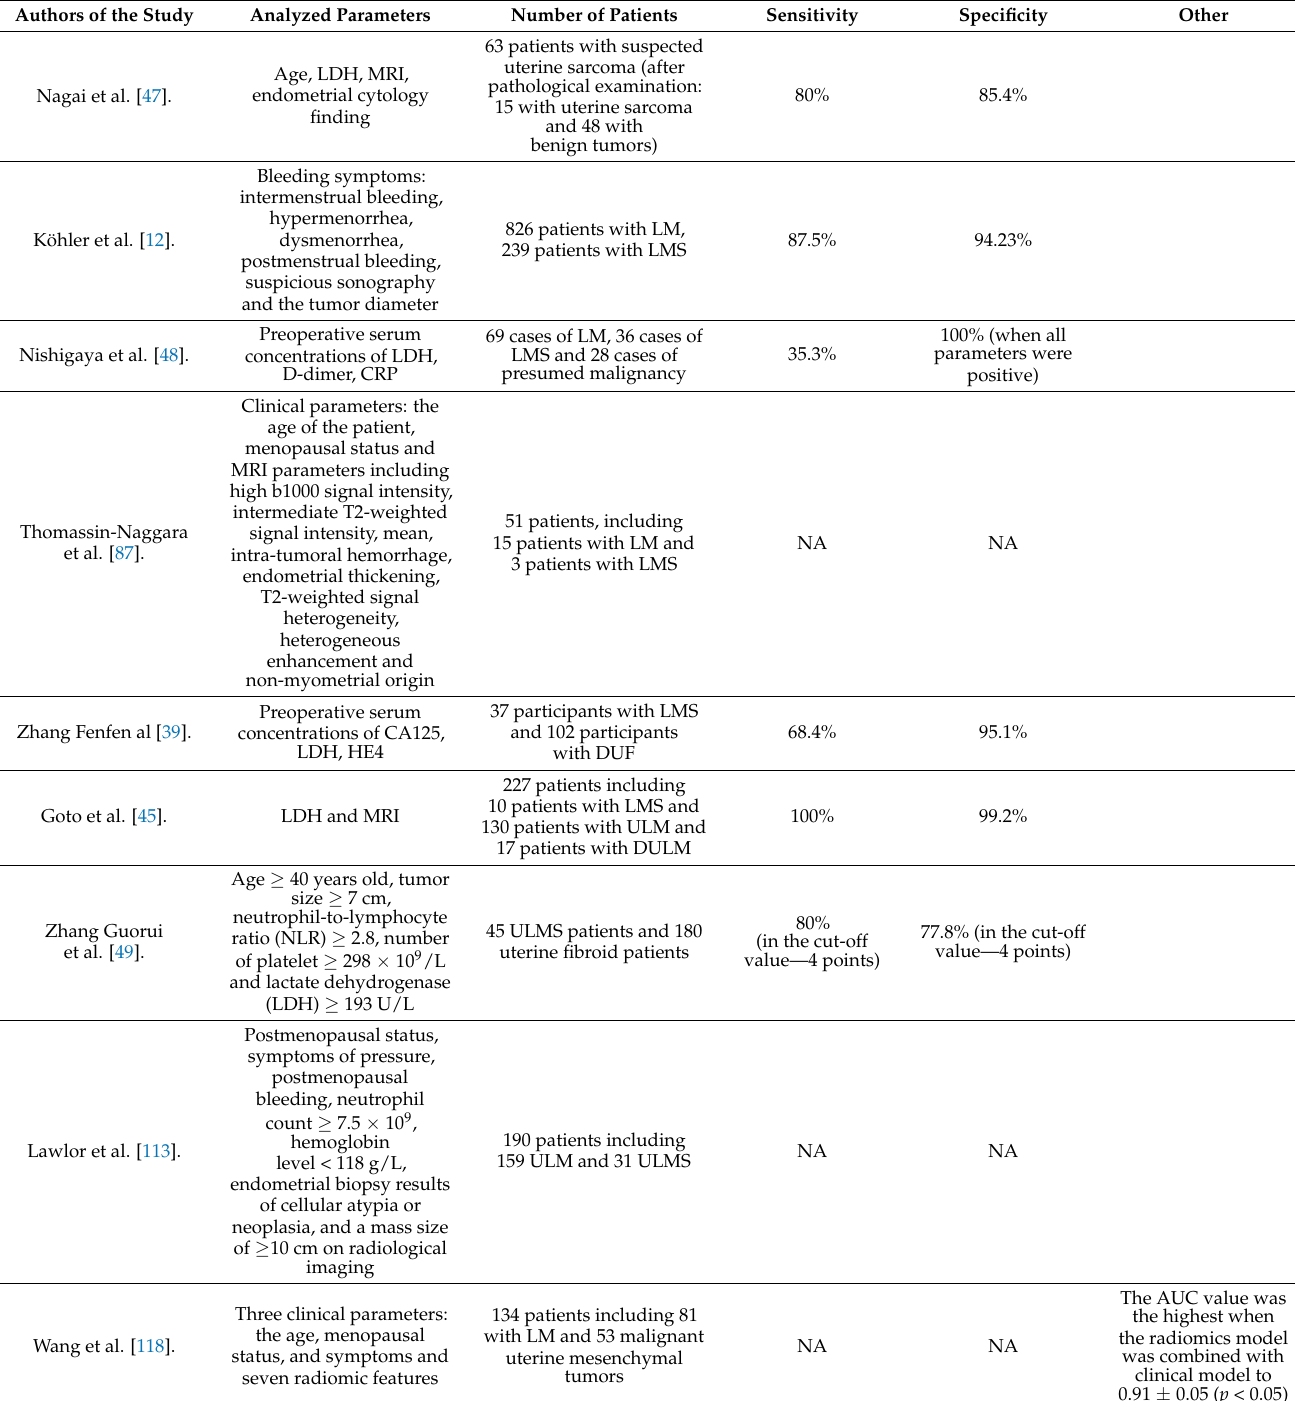
Table 7. The analysis of the available scoring scales (NA—data not